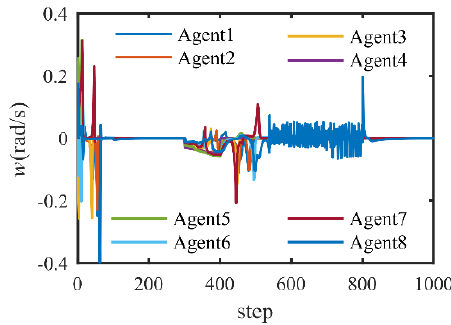
Figure 14. Velocity (test 3).